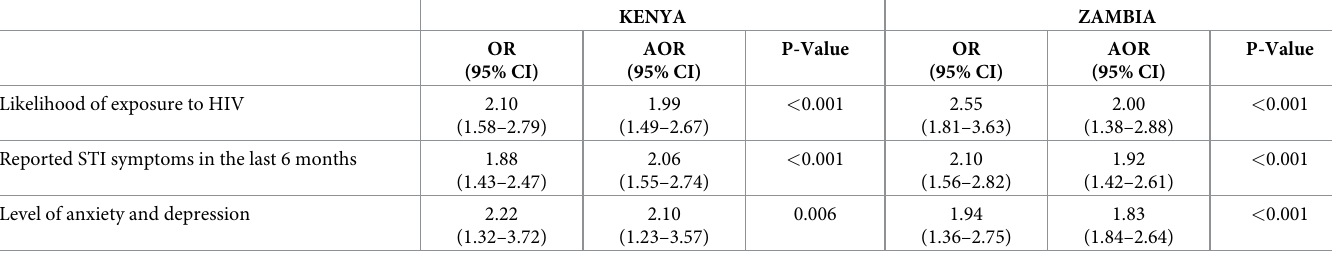
Table 6. Experience of sexual violence with non-partners and association with sexual and mental health outcomes, Kenya and